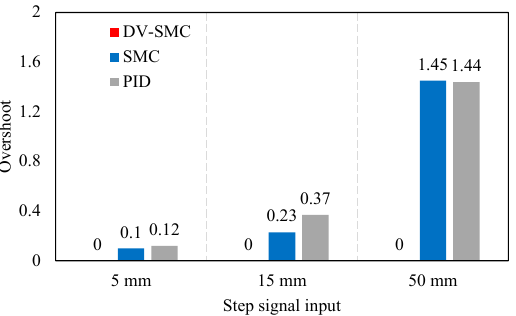
Figure 8. Overshoot of different control strategies.